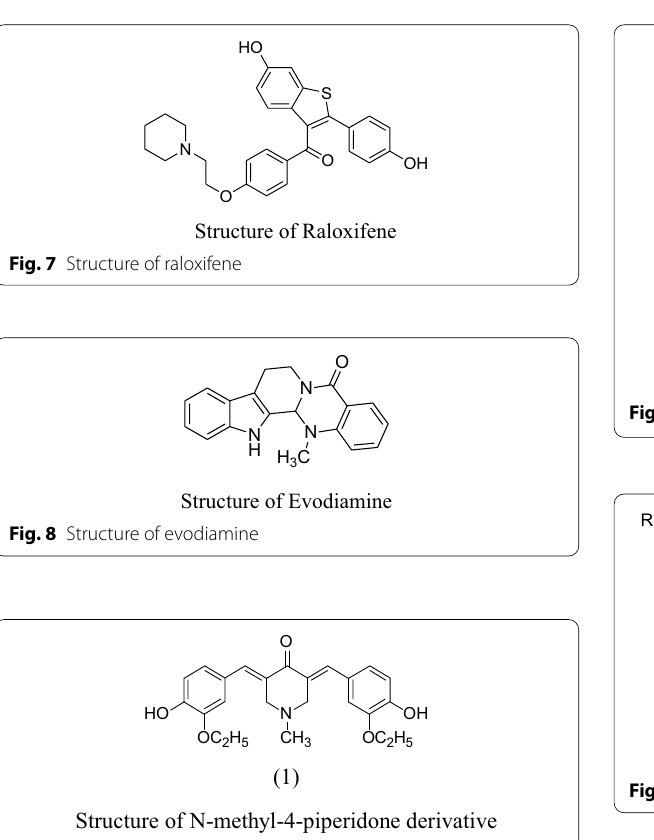
Fig. 11 Structure of hydroxypiperidine derivatives